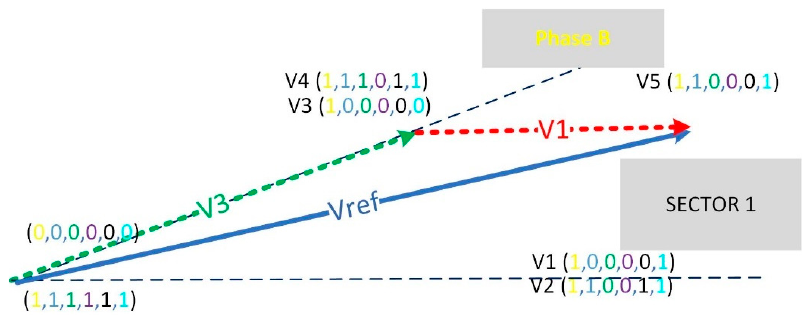
Figure 11. Synthesizing V_ref in the first sector using V3 and V1 only.